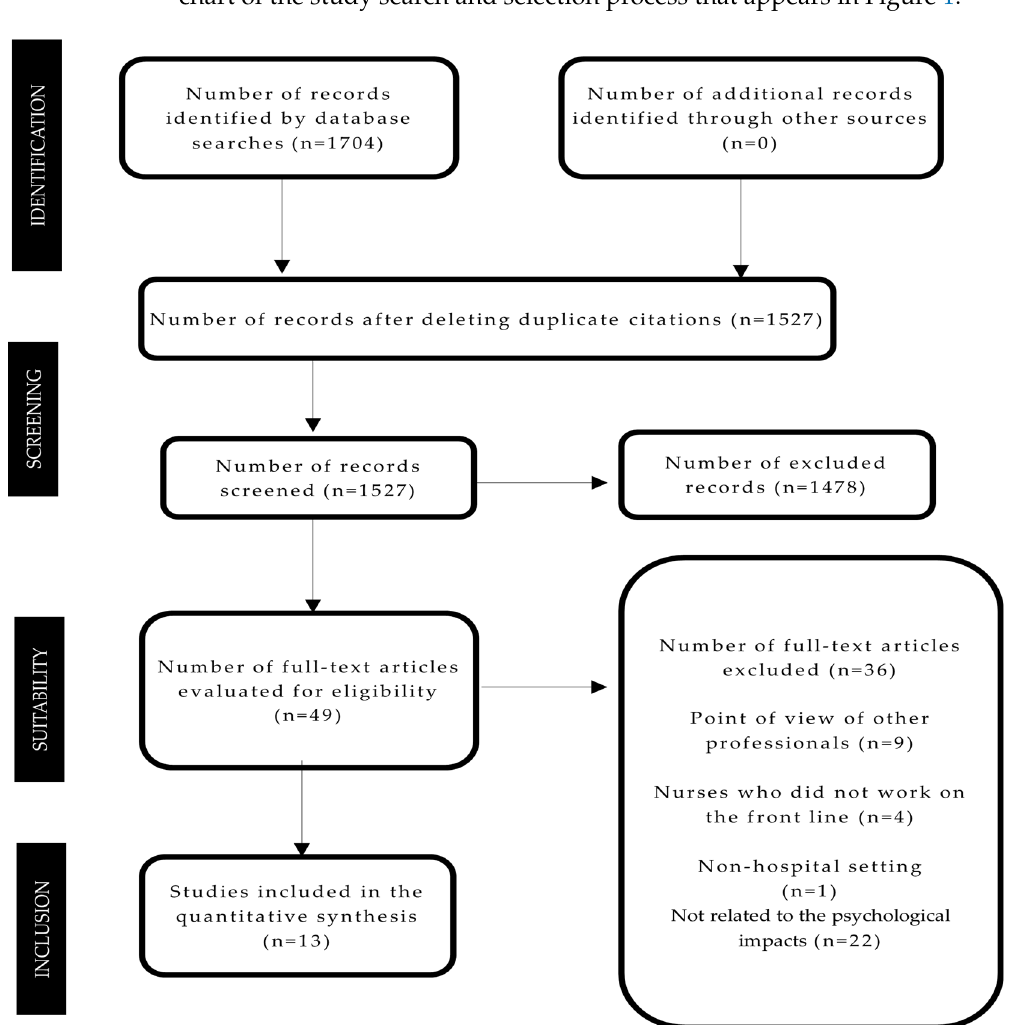
Figure 1. Flow diagram of the study search and selection process.